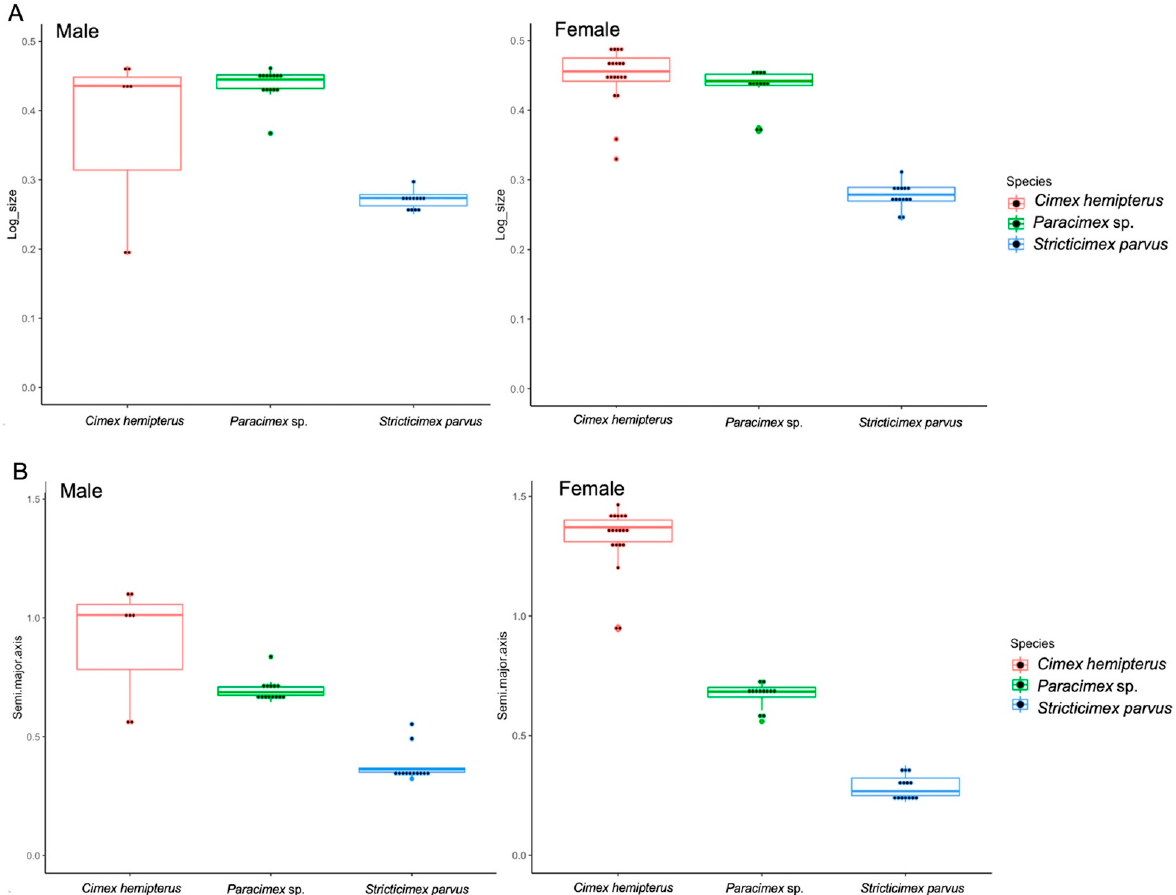
Figure 2. Quantile boxes showing the relative variation in the global size of the pronotum. Varia- tions in size among males (left) and females (right) were derived via ( A ) the linear approach (log- size) and ( B ) outline-based morphometry (semi-major axis of the first ellipse). Boxes show group medians that separate the 25th and 75th percentiles.